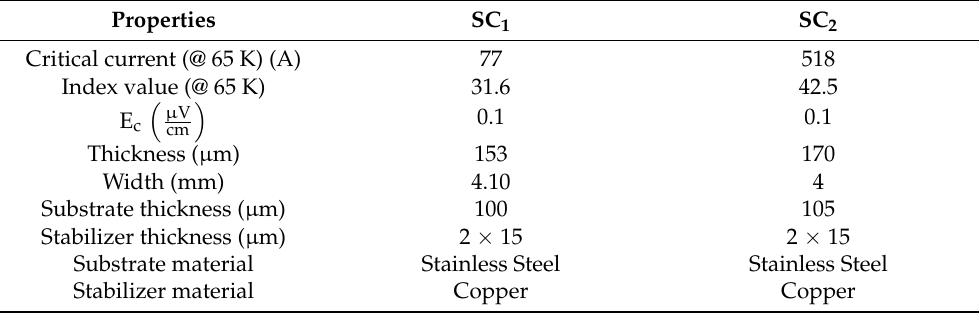
Table 3. The specification of YBCO superconducting tapes used in the understudied DC HTS cables.